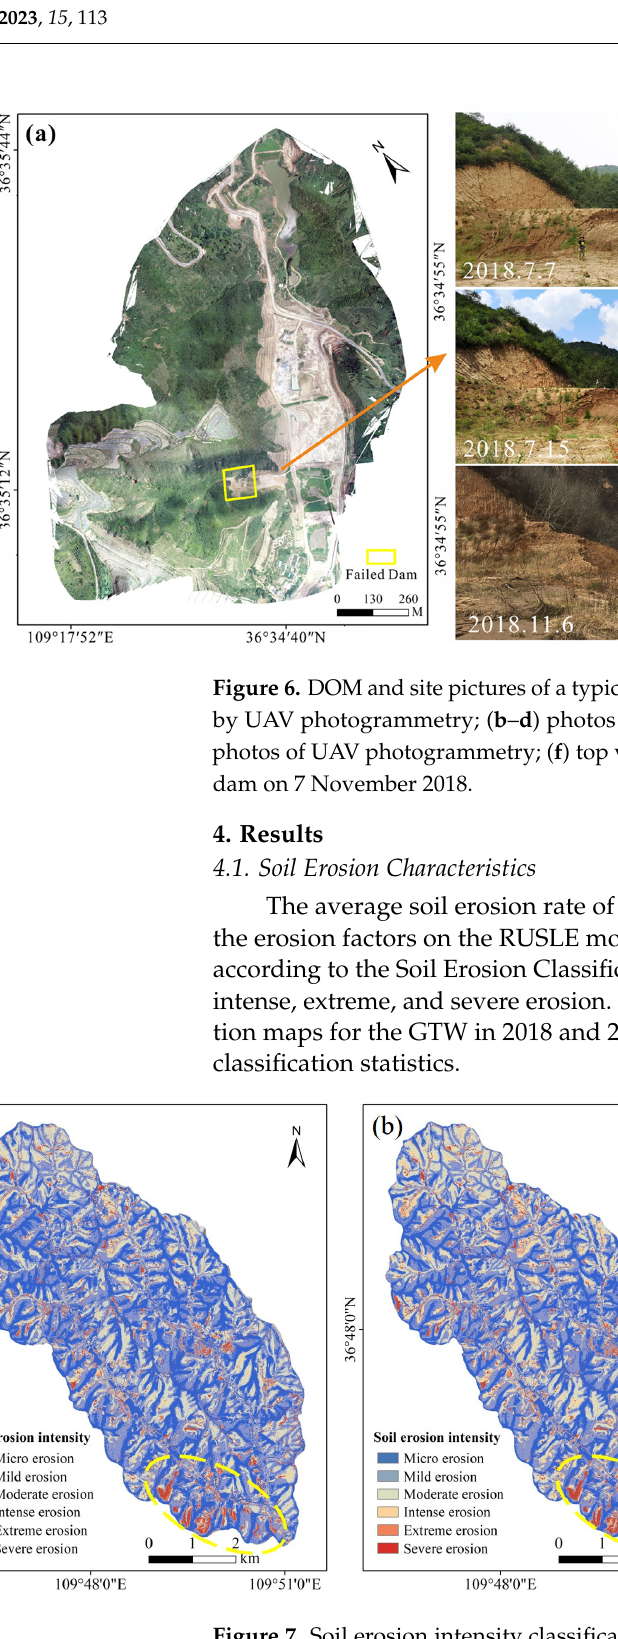
Figure 7. Soil erosion intensity classification map of the GTW obtained after applying the RUSLE model. ( a ) Soil erosion intensity classification map for the GTW in 2018; ( b ) soil erosion intensity classification map for the GTW in 2020; ( c ) change in soil erosion intensity from 2018 to 2020. The yellow dashed outlines in panels ( a , b ) highlight areas of severe erosion.